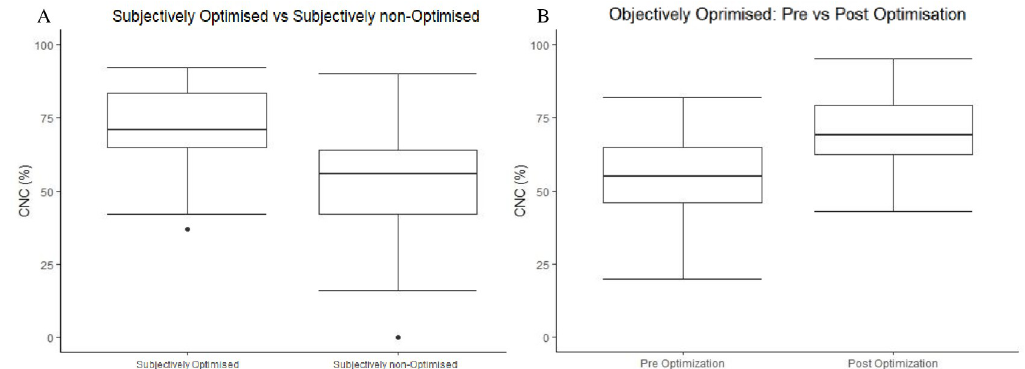
Fig 5. (A) Difference in speech perception scores between the subjectively optimised group and the subjectively non-optimised group. (B) Difference in speech perception scored between the objective optimised group pre-CAEP to